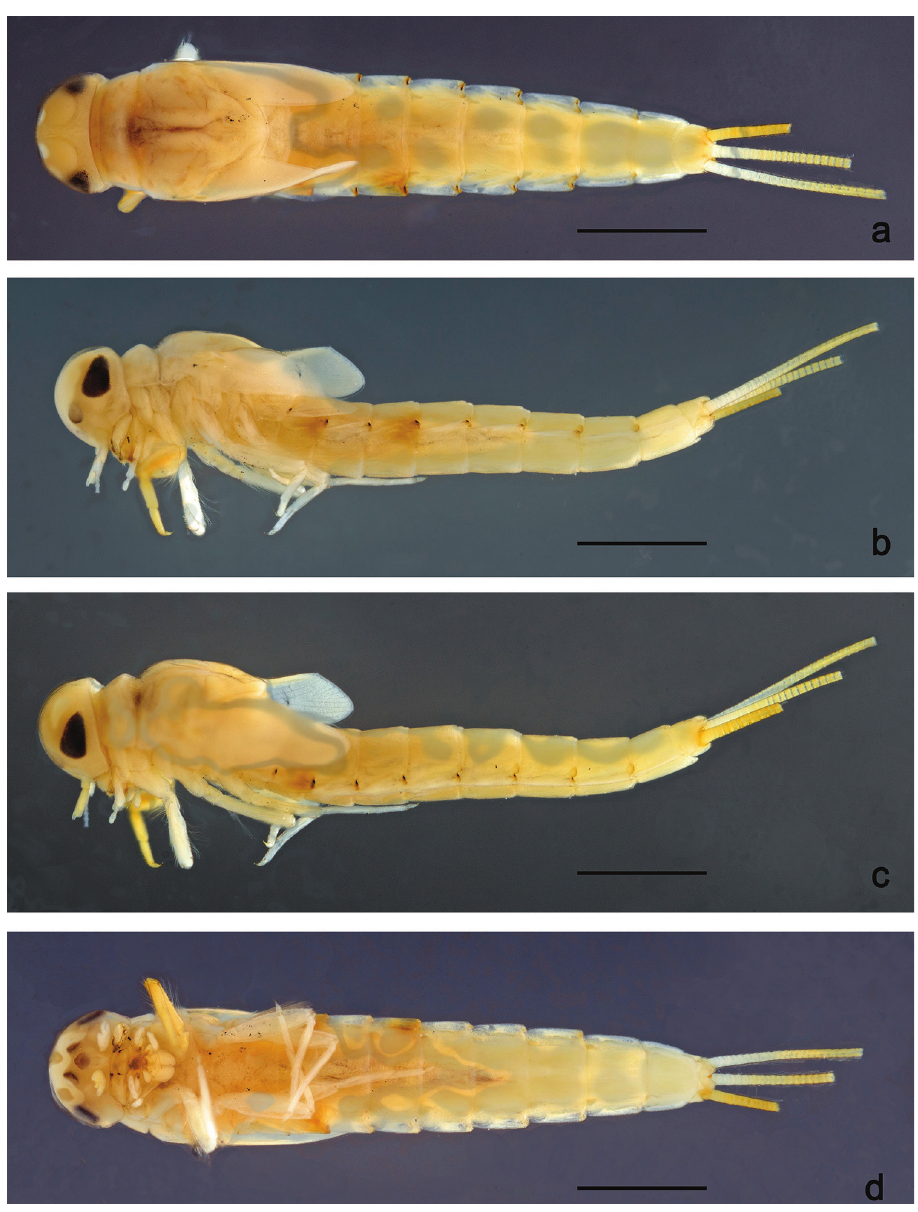
Figure 1. Pedicelliops capillifer gen. et sp. nov., habitus, larva a dorsal view b, c lateral views d ventral view. Scale bars: 1